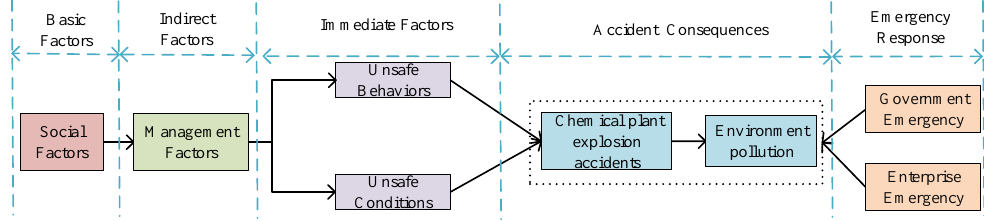
Figure 2. The occurrence and development process of chemical plant explosion accidents (CPEAs).